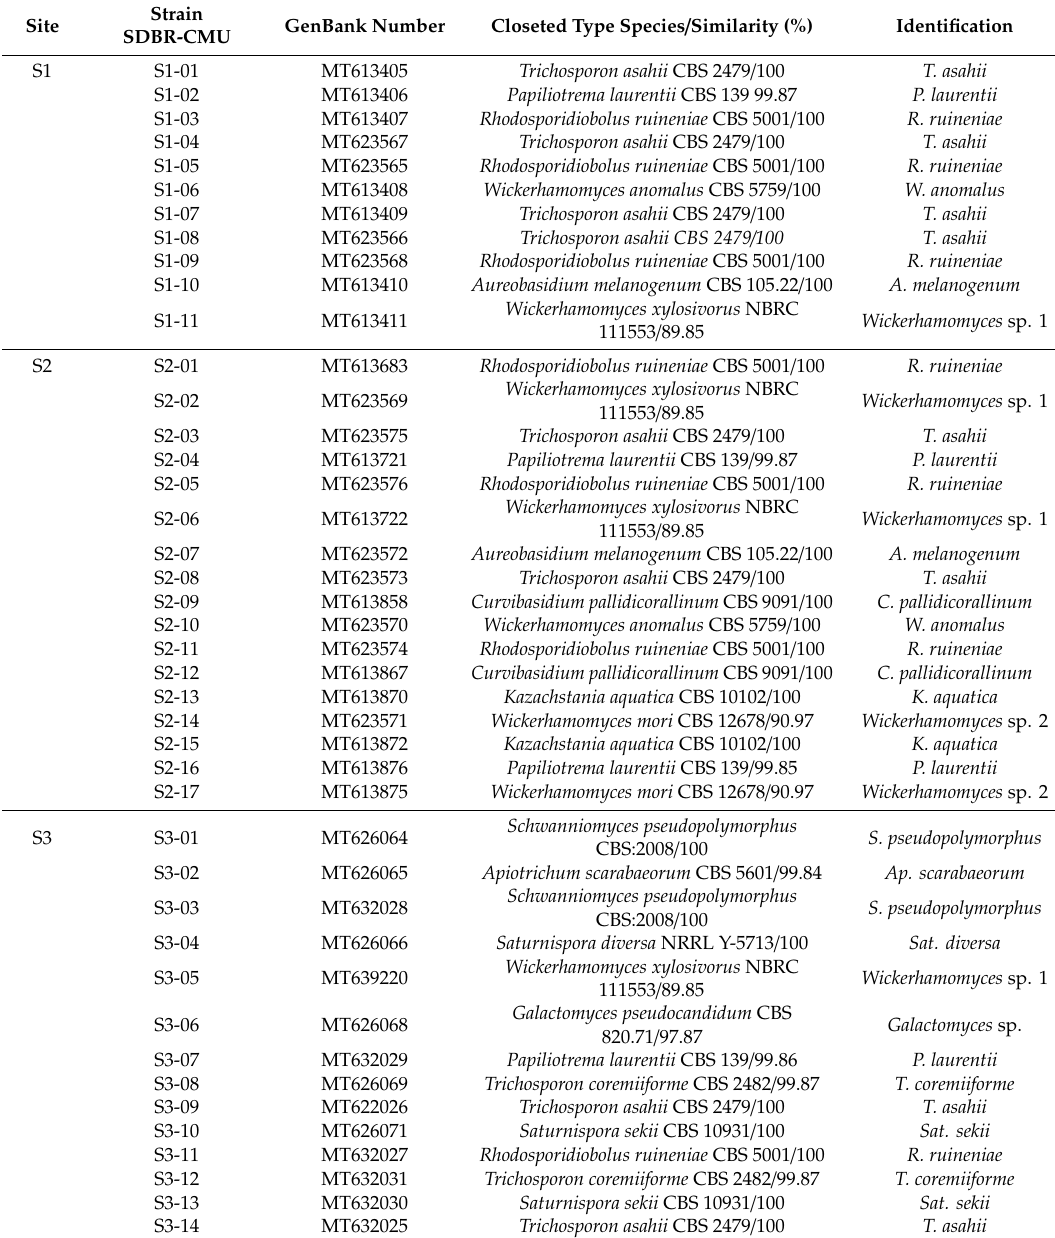
Table 2. Identification of yeast strains obtained in this study based on analysis of the D1 / D2 region of the large subunit ribosomal RNA (LSU rRNA)